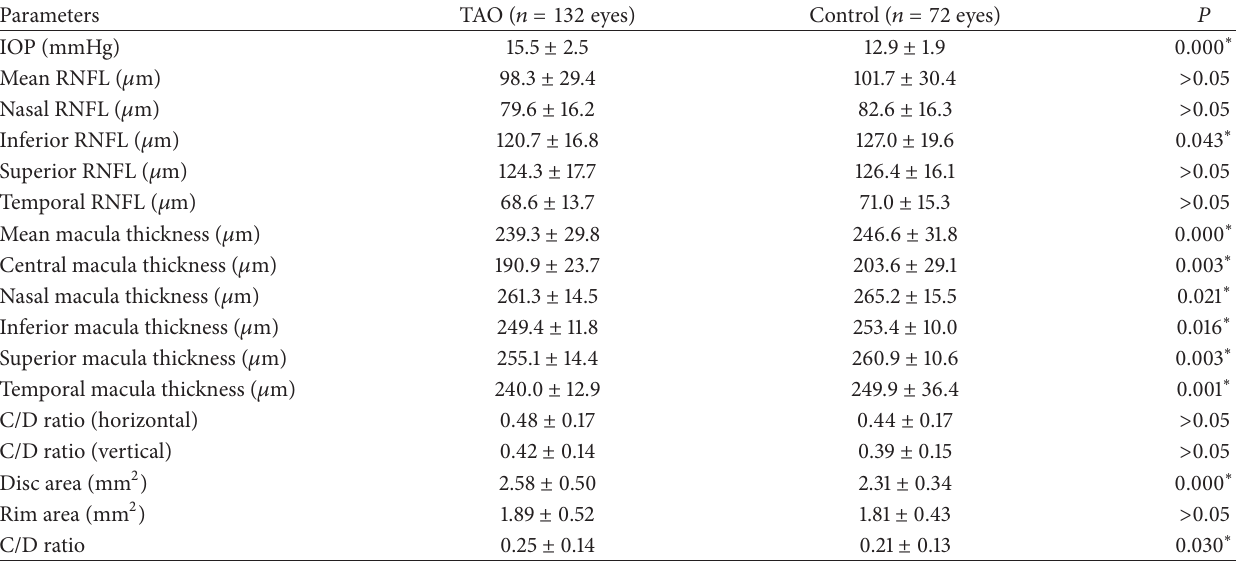
Table 2: Comparison of IOP and OCT parameters between the patients with thyroid-associated ophthalmopathy (TAO) and control group.